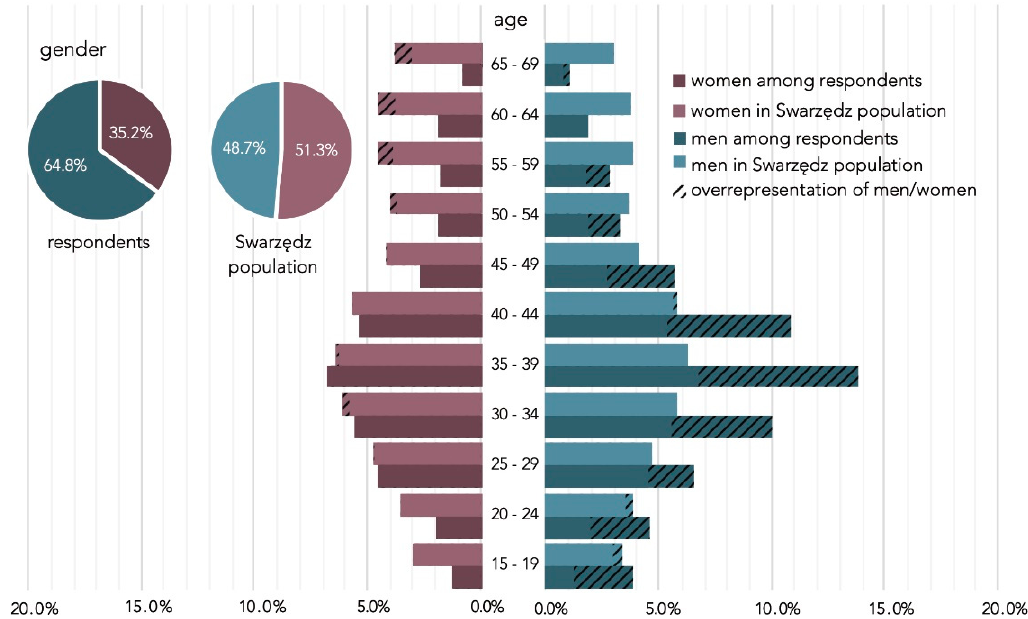
Figure 5. Age and gender structure of respondents in Swarz ę dz commune. Source: own elaboration based on geo-questionnaire results and statistics Poland data.